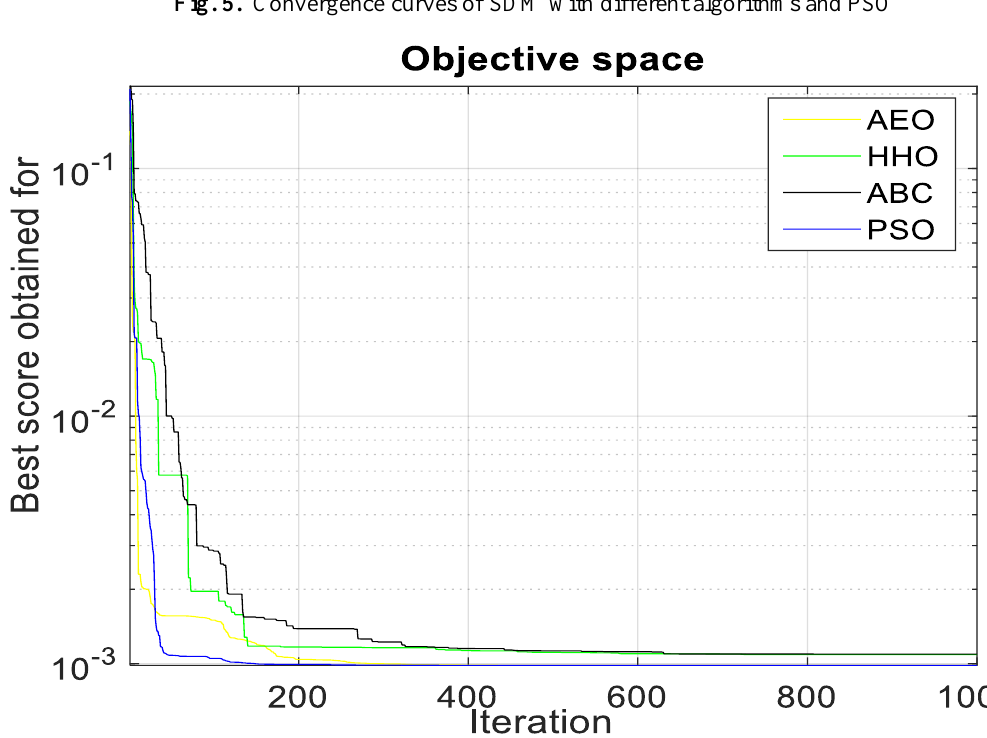
Fig. 5. Convergence curves of SDM with different algorithms and PSO